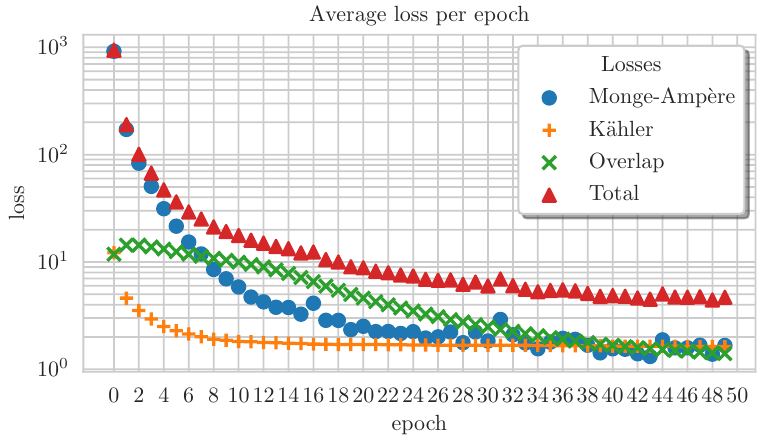
Figure 7 . Change in loss during training for the SU(3) -structure